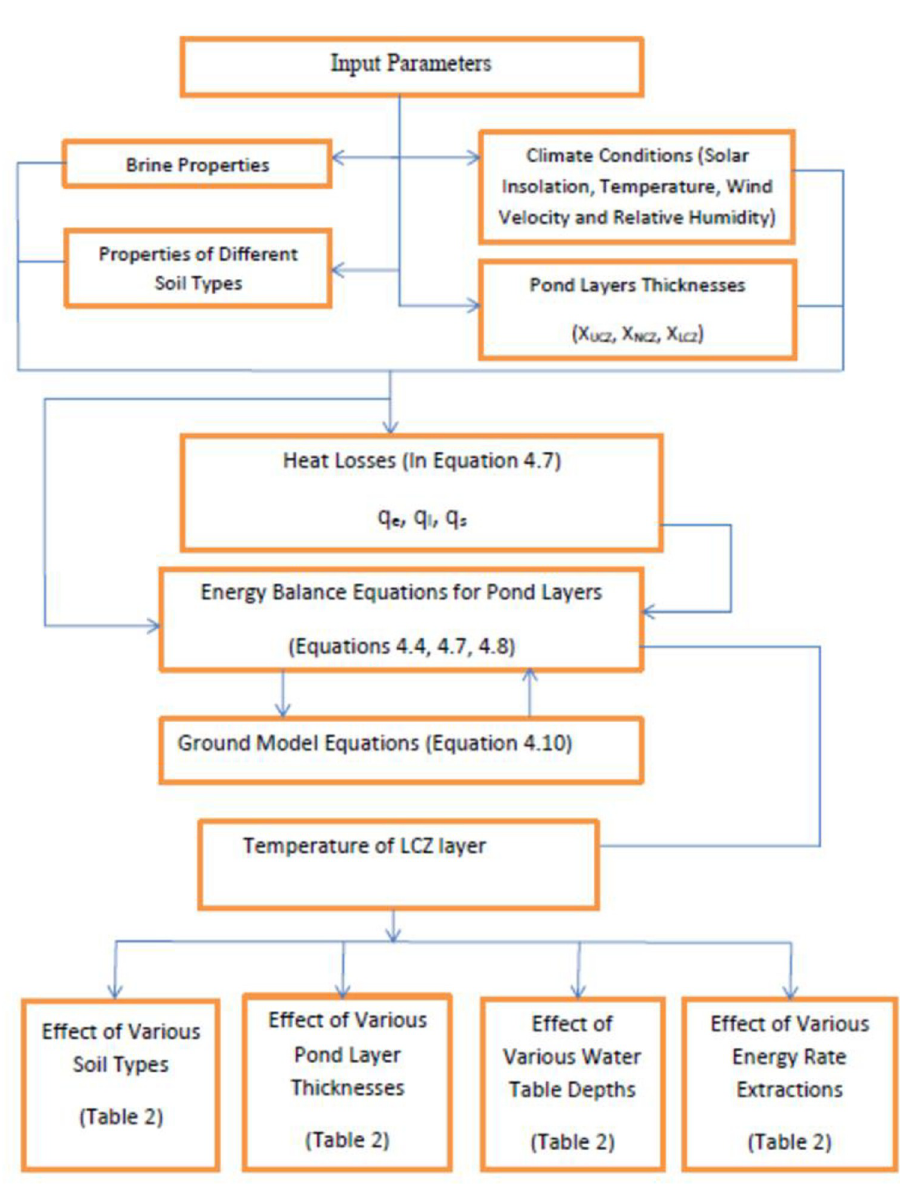
Fig 2. Flow chart showing solution procedure on